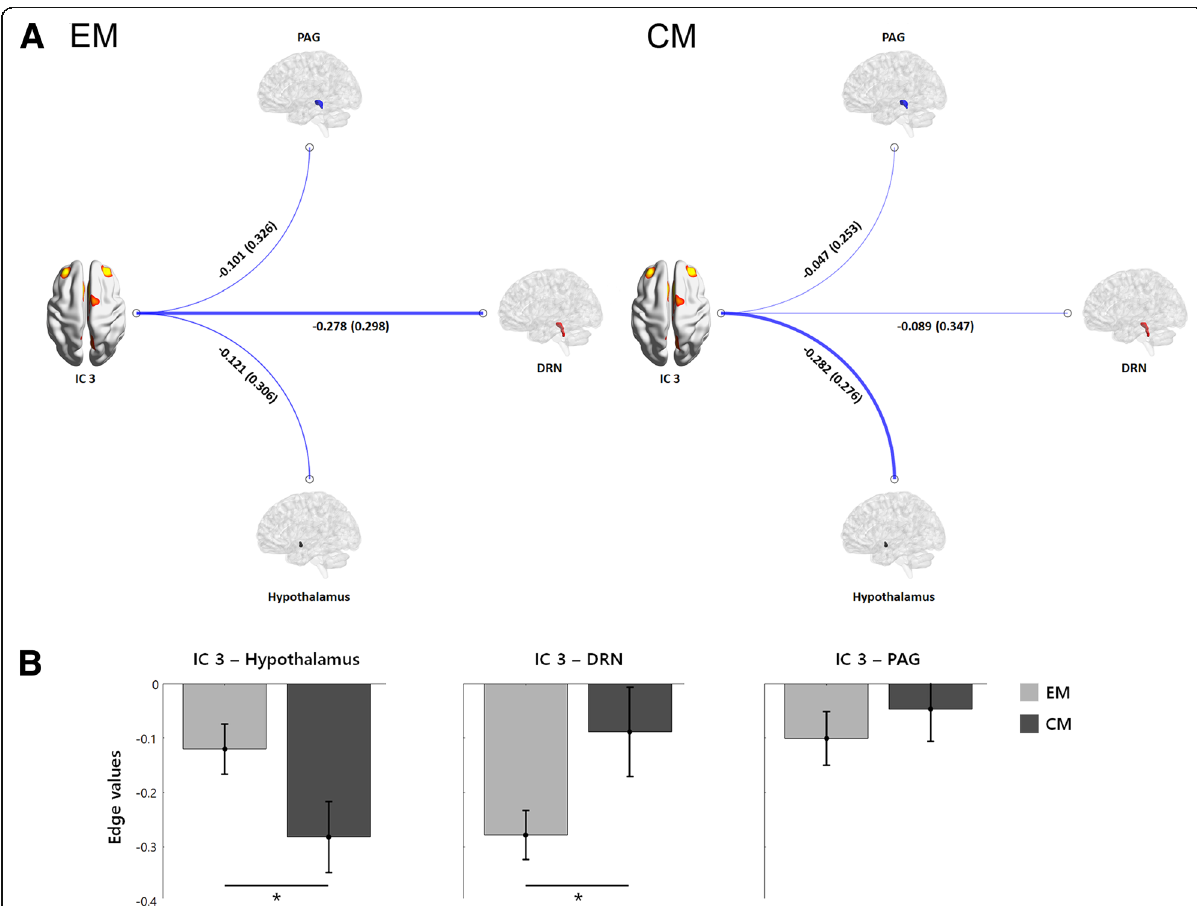
Table 3 Univariable and multivariable analysis of between-group difference in the connectivity of the pain matrix Univariable 0.0462